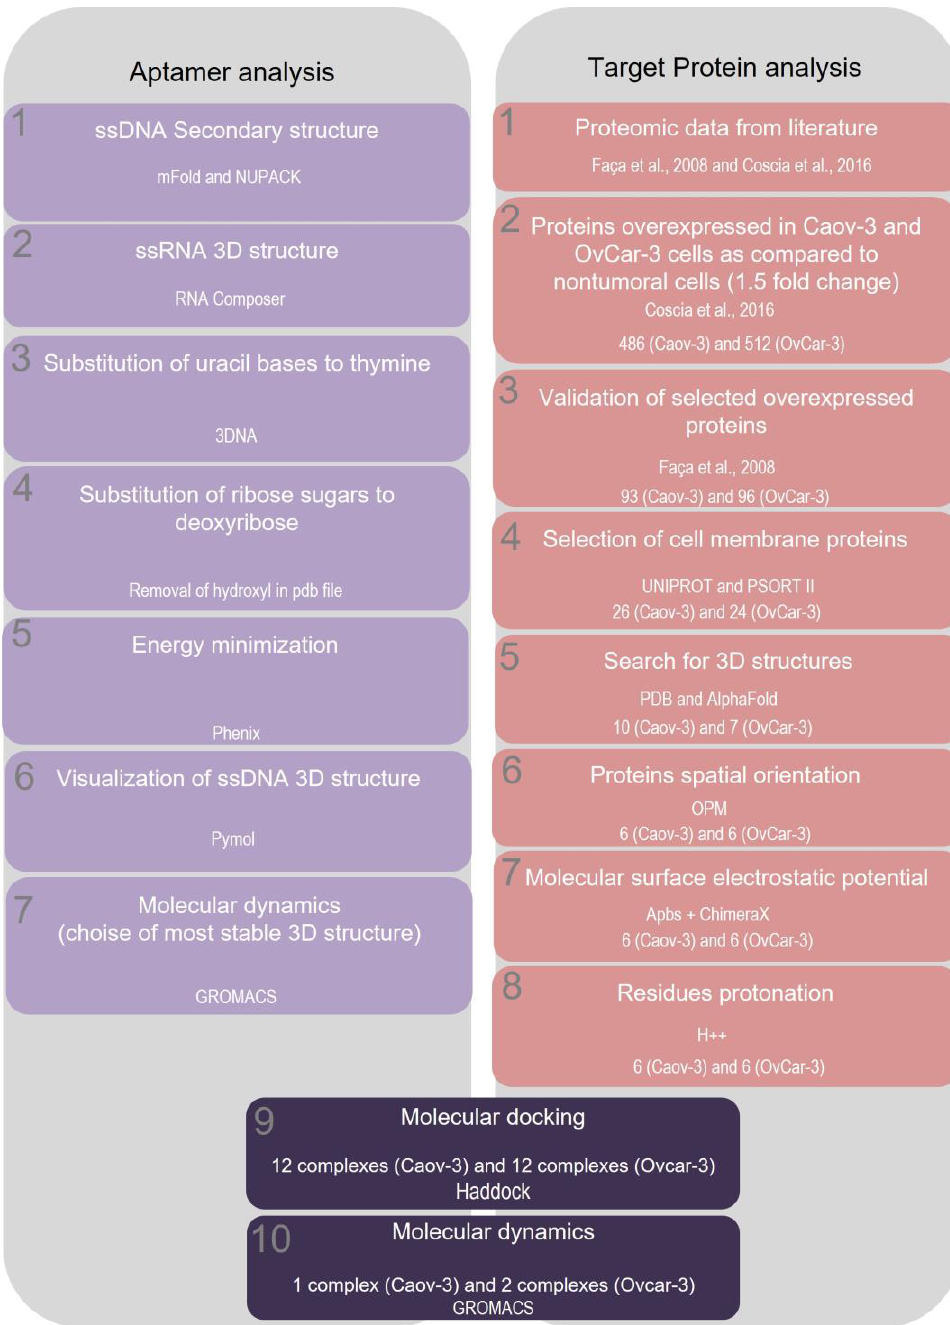
Figure 3. Workflow demonstrating the sequential steps for aptamer analysis and potential protein target analysis. Proteomic data was obtained by Faça et al., 2008 and Coscia et al., 2016 [17,18].